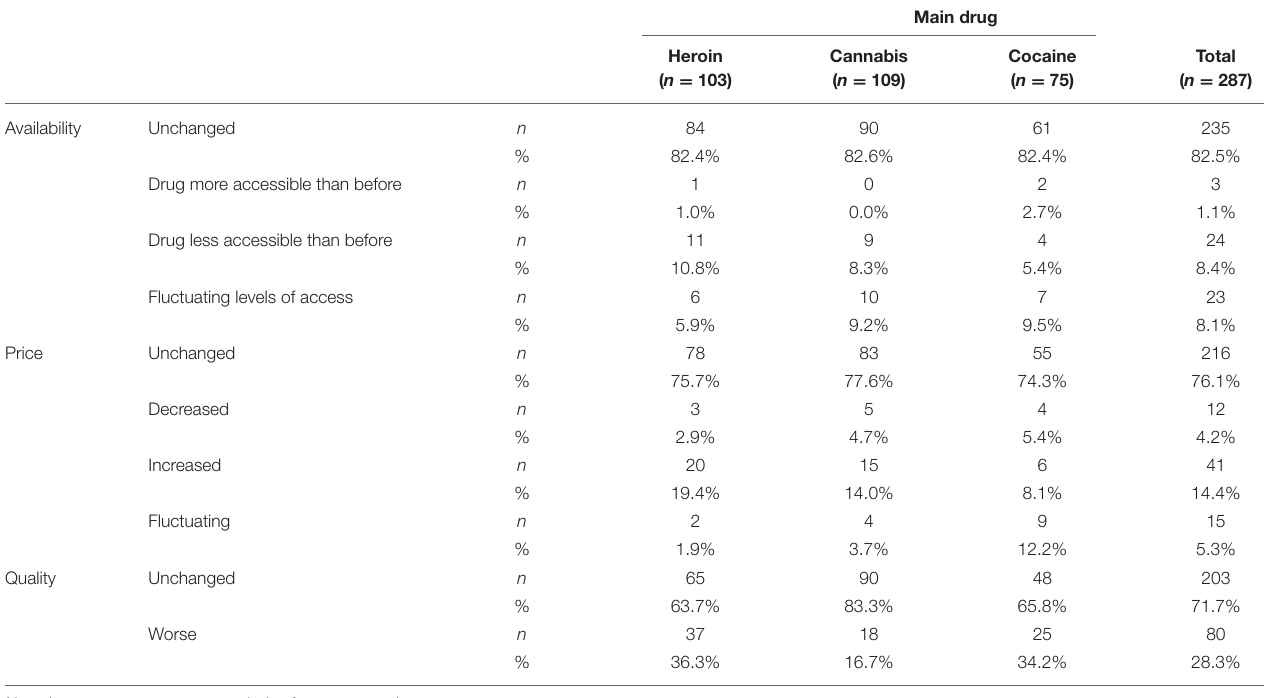
TABLE 1 | Availability, price, and quality of the main